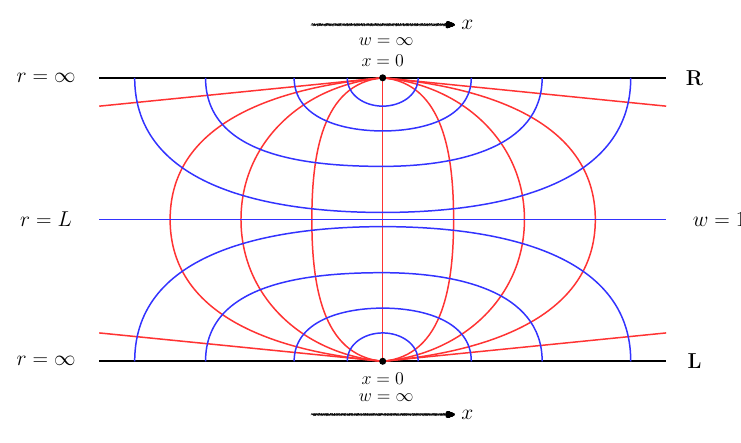
Figure 1 . We draw the constant t section of the BTZ spacetime where we show ( (cid:22); w ) together with ( r; x ) coordinates. The middle line with w = 1 and r = L represents the horizon. The red lines are representing constant (cid:22) surfaces whereas the blue lines are constant w surfaces. The top/ bottom line represents the spatial direction of the R/L boundary